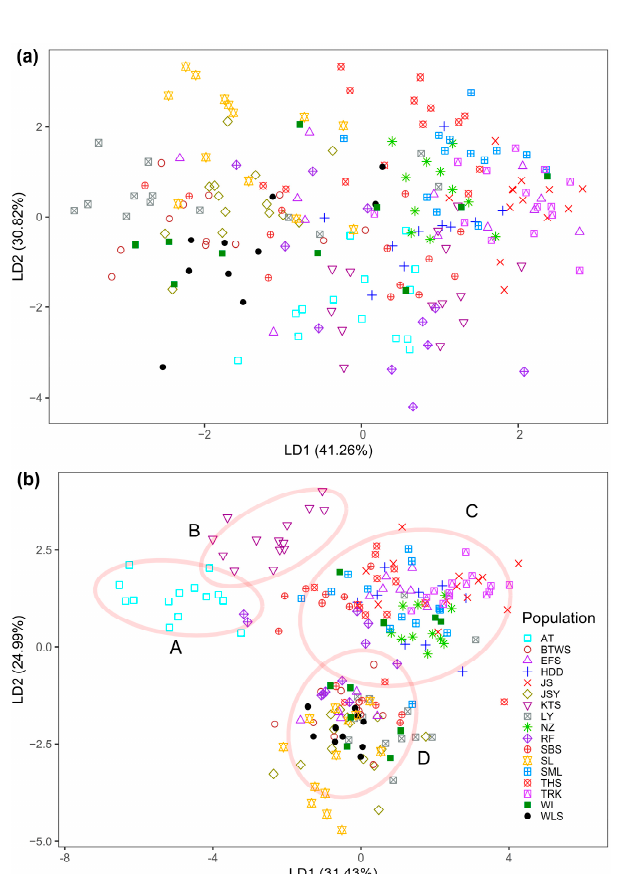
Figure 2. Analysis of epigenetic homogeneous groups of 211 individuals of Zingiber kawagoii based on the total ( a ) mMSAP and ( b ) uMSAP variation using DAPC. The first two linear discriminants described 72.08 and 56.42% of the total mMSAP and uMSAP variation, respectively.